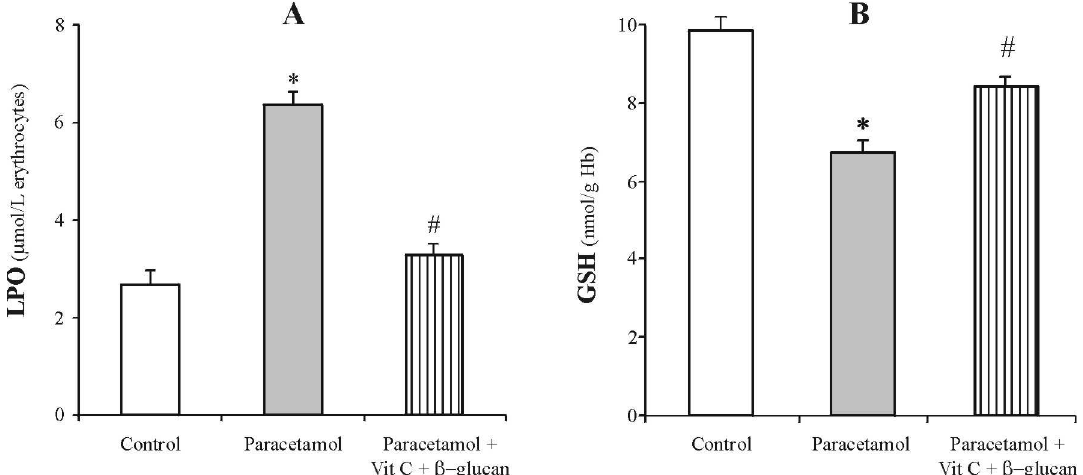
Figure 1. Effects of vitamin C and b -glucan on oxidative stress parameters (LPO and GSH) in blood of paracetamol-treated